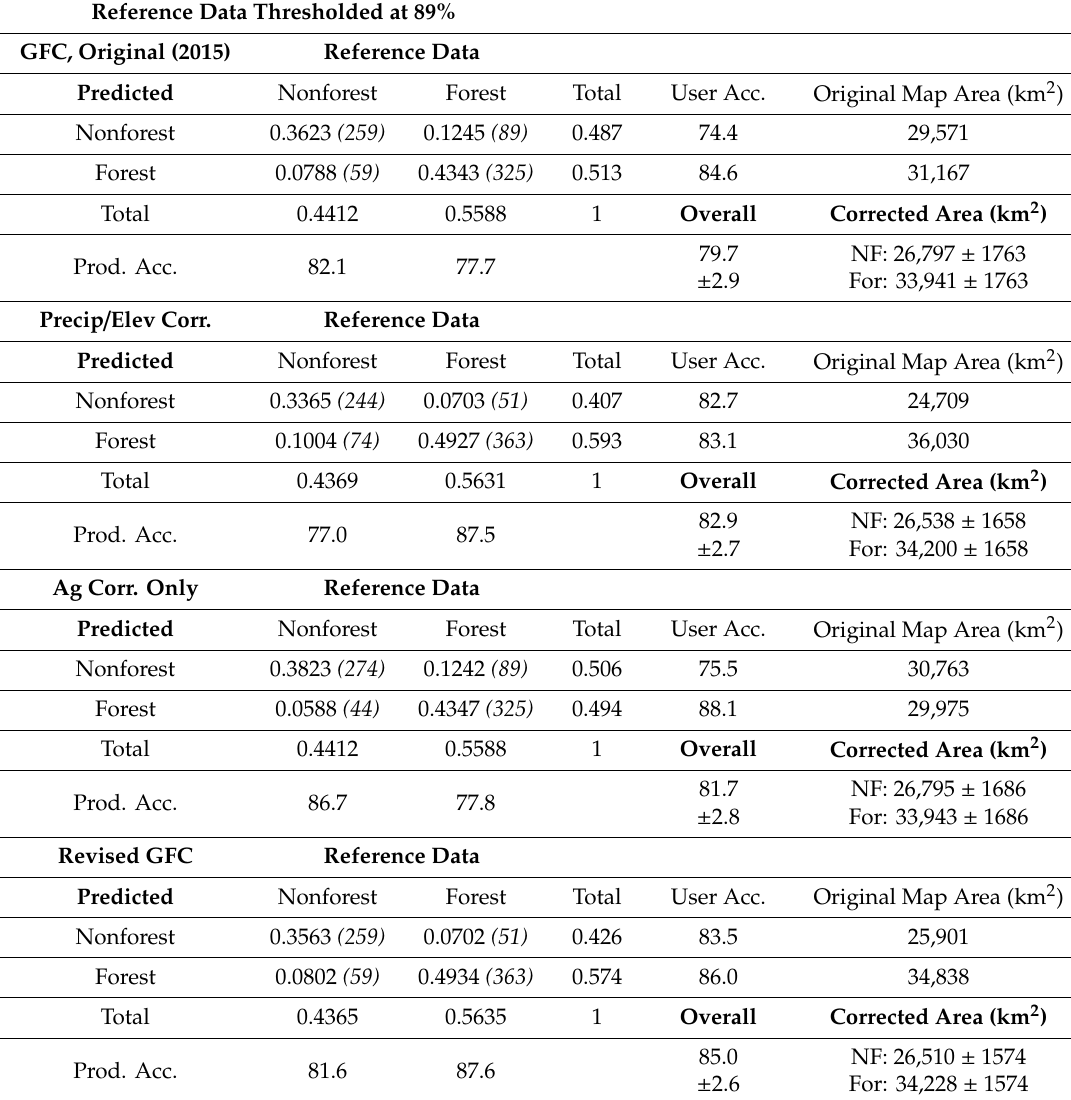
Table A4. Area-corrected user’s, producer’s, and overall accuracy of di ff erent forest / non-forest maps at the 89% forest cover threshold. Overall accuracy and corrected area estimates are shown (mean ± 95% confidence interval), with original confusion matrix point counts in italic